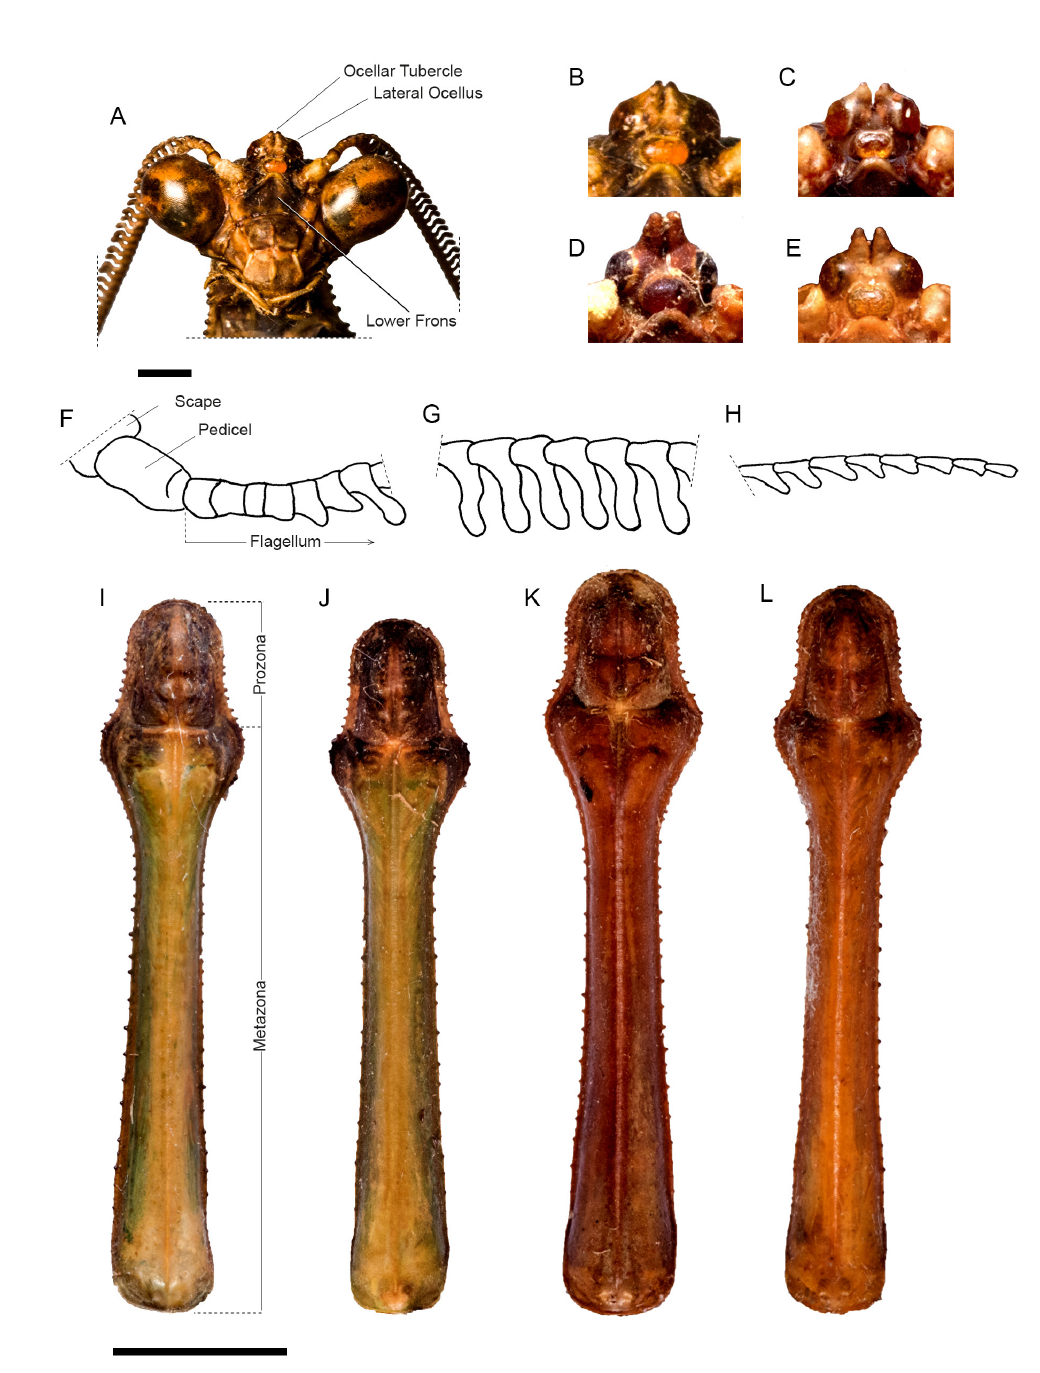
Fig. 3. Vates phoenix sp. nov., male morphology. A . Head, frontal view, holotype (MNRJ-ENT6-28441). – B – E . Variation in ocellar tubercles across localities (not to scale). B . Fazenda Recanto, holotype (MNRJ- ENT6-28441). C. Reserva Ecológica de Guapiaçu, paratype (MNRJ-ENT6-28447). D . Jussaral, paratype (MNRJ-ENT6-28449). E . Corcovado, paratype (MNRJ-ENT6-28448). – F – H . Antenna, highlighting sectional variation of antennomeres. F . Basal section. G . Mid section. H . Apex. – I – L . Pronota, highlighting size variation. I . Fazenda Recanto, holotype (MNRJ-ENT6-28441). J . Reserva Ecológica de Guapiaçu, paratype (MNRJ-ENT6-28447). K . Jussaral, paratype (MNRJ-ENT6-28449). L . Angatuba, paratype (MNRJ-ENT6-28456). Scale bars: A = 1 mm; I–L = 5